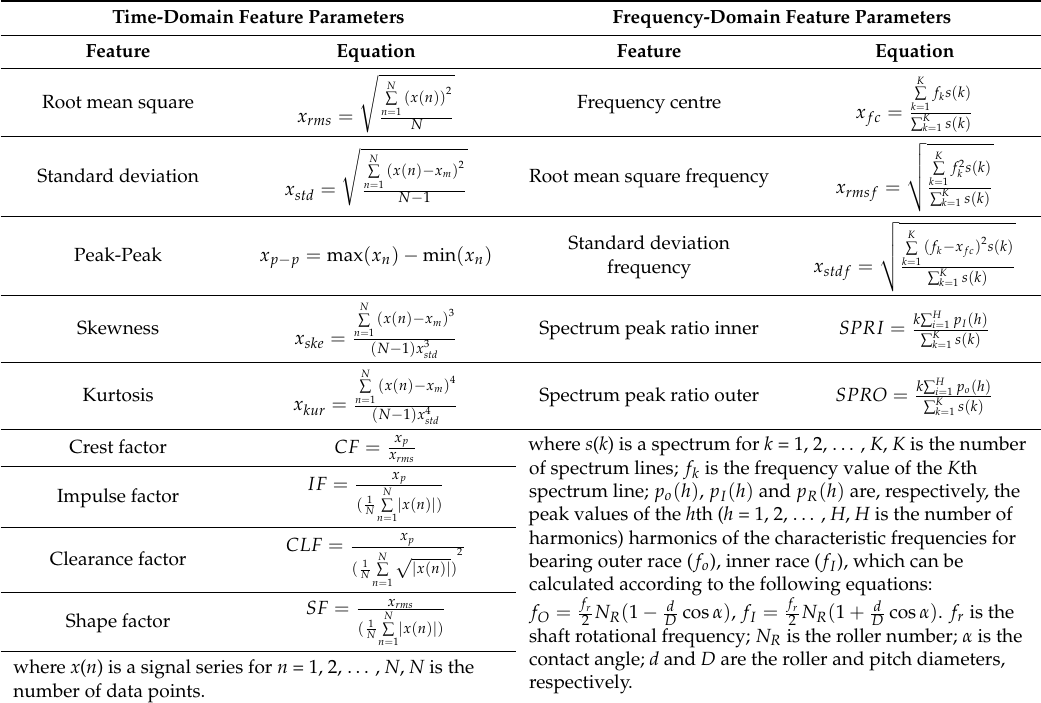
Table 1. The traditional feature